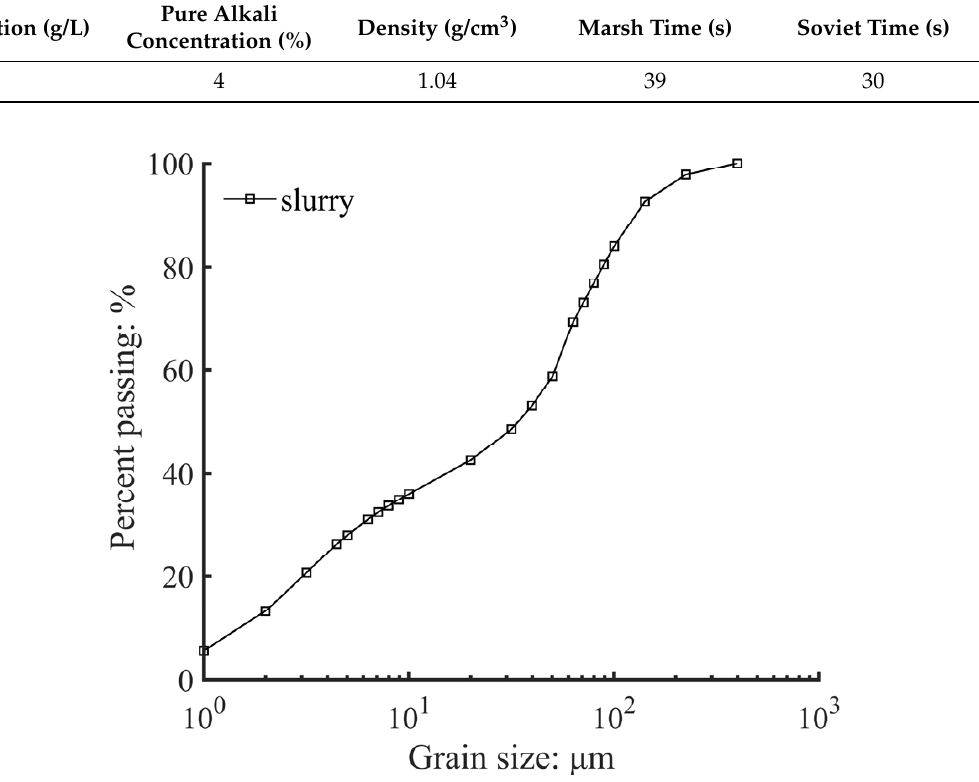
Table 3. Fresh slurry properties in the tests.